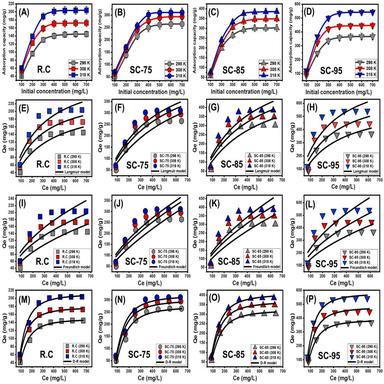
Shows the effect of the MPn concentration on its adsorption capacities by R.C, SC-75, Sc-85, and SC-95 (A, B, C, and D), the fitting of the MPn adsorption results with Langmuir model (E, F, G, and H), fitting of the MPn adsorption results with Freundlich model (I, J, K, and L), and fitting of the MPn adsorption results with D-R model (M, N, O, and P).